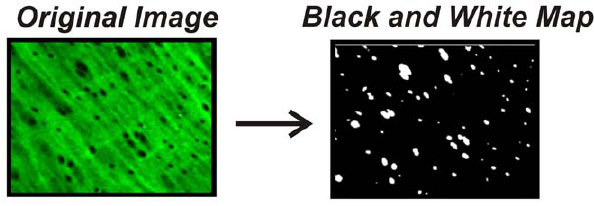
Figure 1. Depiction of internal elastic lamina fenestration and conversion for fenestrae quantification. Autofluorescence of the internal elastic lamina was imaged via laser scanning confocal microscopy. Following 3-dimensional volume rendering, images were recorded and reconstructed using Volocity 6.0.0 to produce a black and white map which allowed for detection of fenestrae via Image J software analysis.